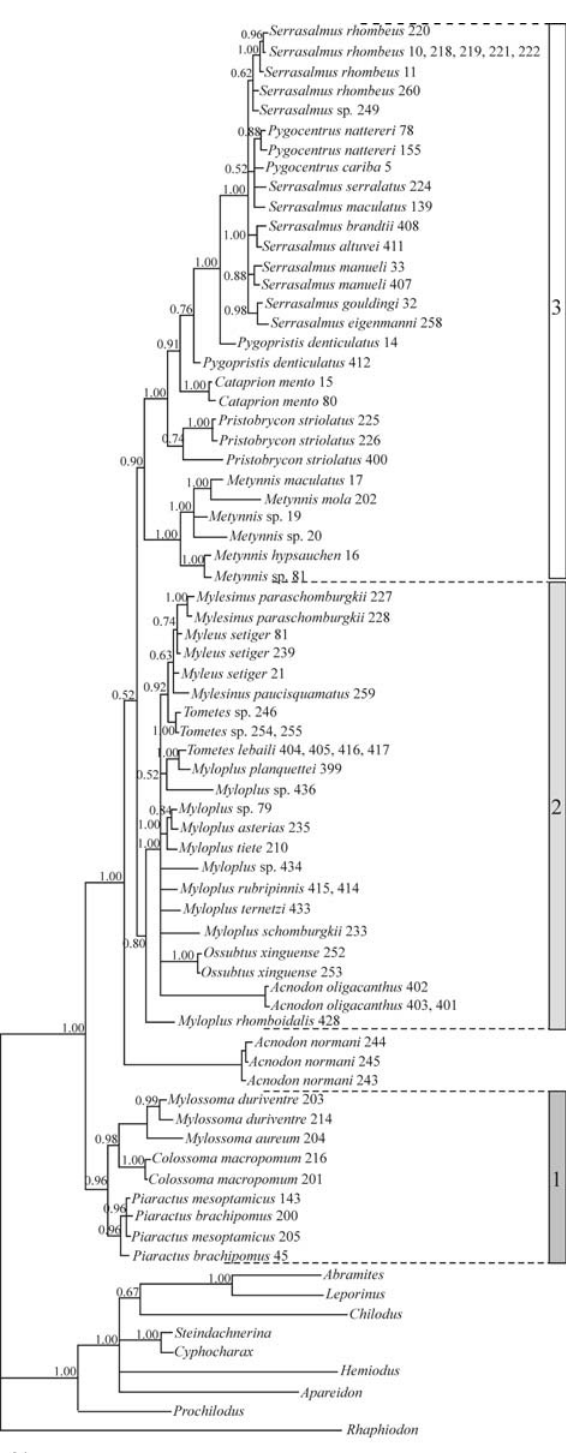
Figure 2 - Phylogeny of the Serrasalmidae obtained with Bayesian inference based on 12S and 16S mtDNA sequences (890 bp) and indel characters (58 characters). The combined data were partitioned into two categories, each withitsindependentmodel(Nst=6andrates=pinvarforDNA,andthestan- dardmodelwithrates=gammaforindelcharacters,seetextformoredetails). Numbers next to nodes are posterior probabilities (the lower value of two in- dependent runs are shown) reflecting partition frequencies obtained in the majority rule-consensus of all post-burnin trees. The three main clades are highlighted: (1) pacu clade, (2) Myleus calde, (3) piranha